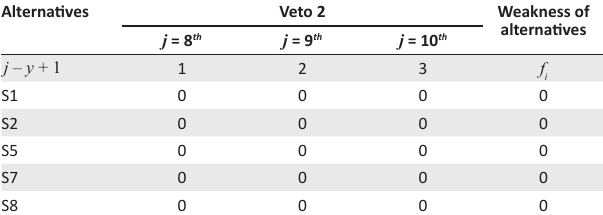
TABLE 13: Veto stage to the lower quartile.